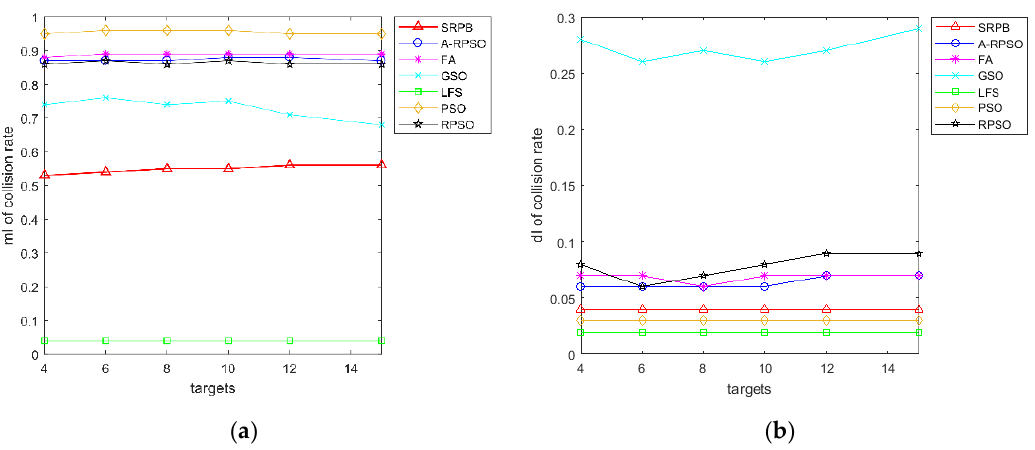
Figure 13. Collision rate of the strategies with various numbers of targets and 50 robots. ( a ) mI of collision rate; ( b ) dI of collision rate.